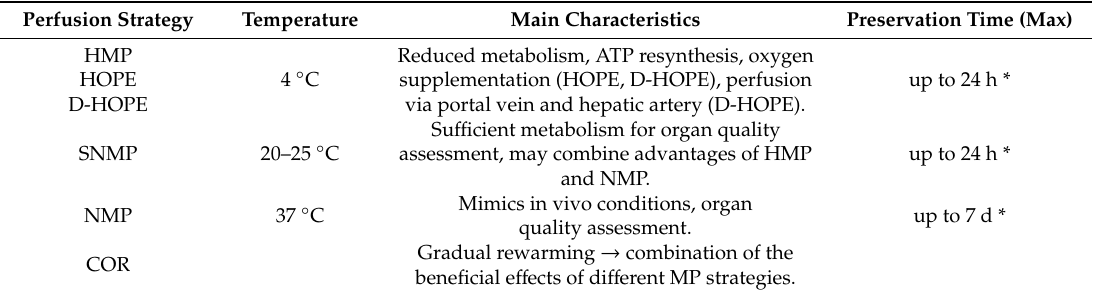
Table 1. Diverse preservation strategies of machine perfusion, depending on temperature and oxygen